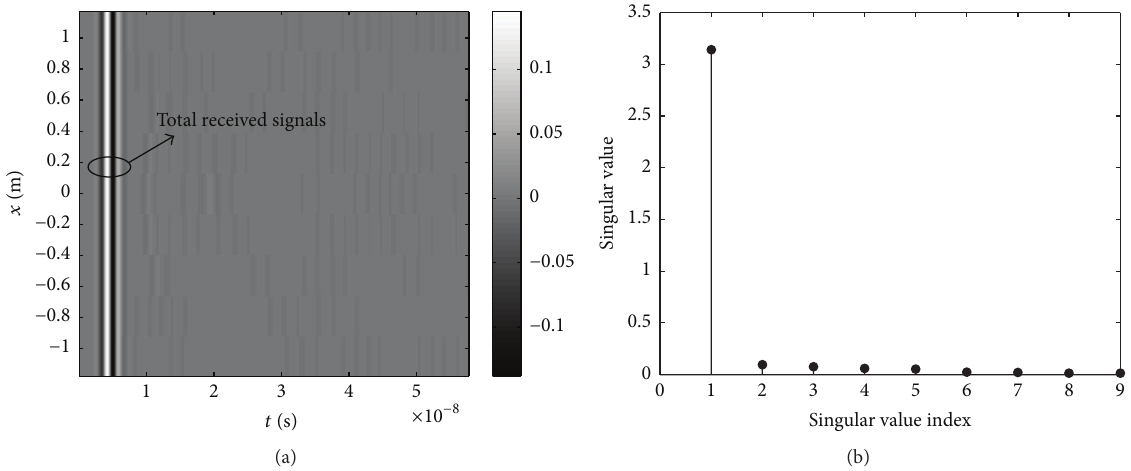
Figure 4: B-scan data for the total received fields and its singular values: (a) B-scan data and (b) singular values.